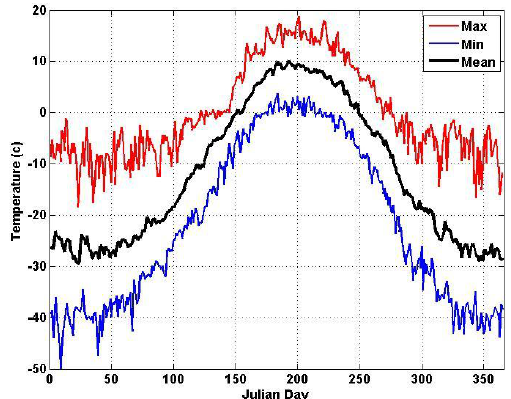
Fig. 4. NNR daily minimum, maximum, and mean for Figure 4. NNR daily minimum, maximum, and mean for 1961-1988. This mean is what we used for the ‘modern’ era in comparisons with paleoconditions.